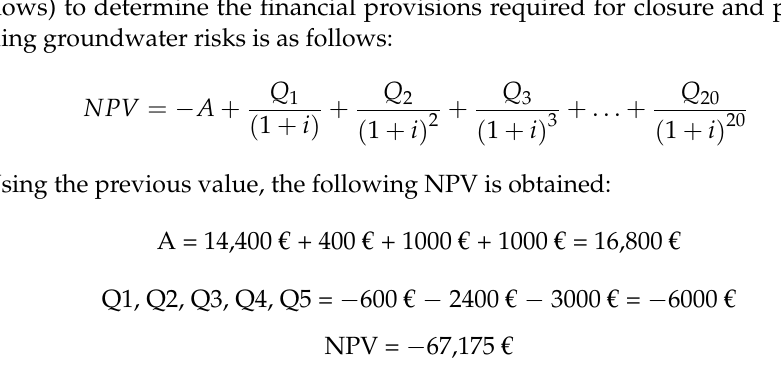
Figure 12. Cash flow for the future 20 years.